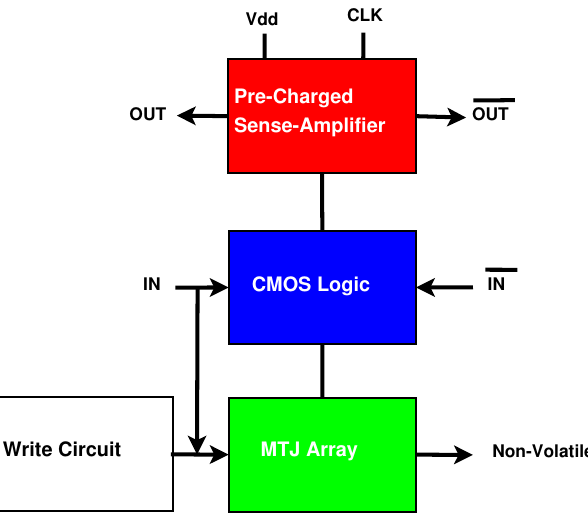
Figure 5. Generalized form of CMOS/MTJ circuits.